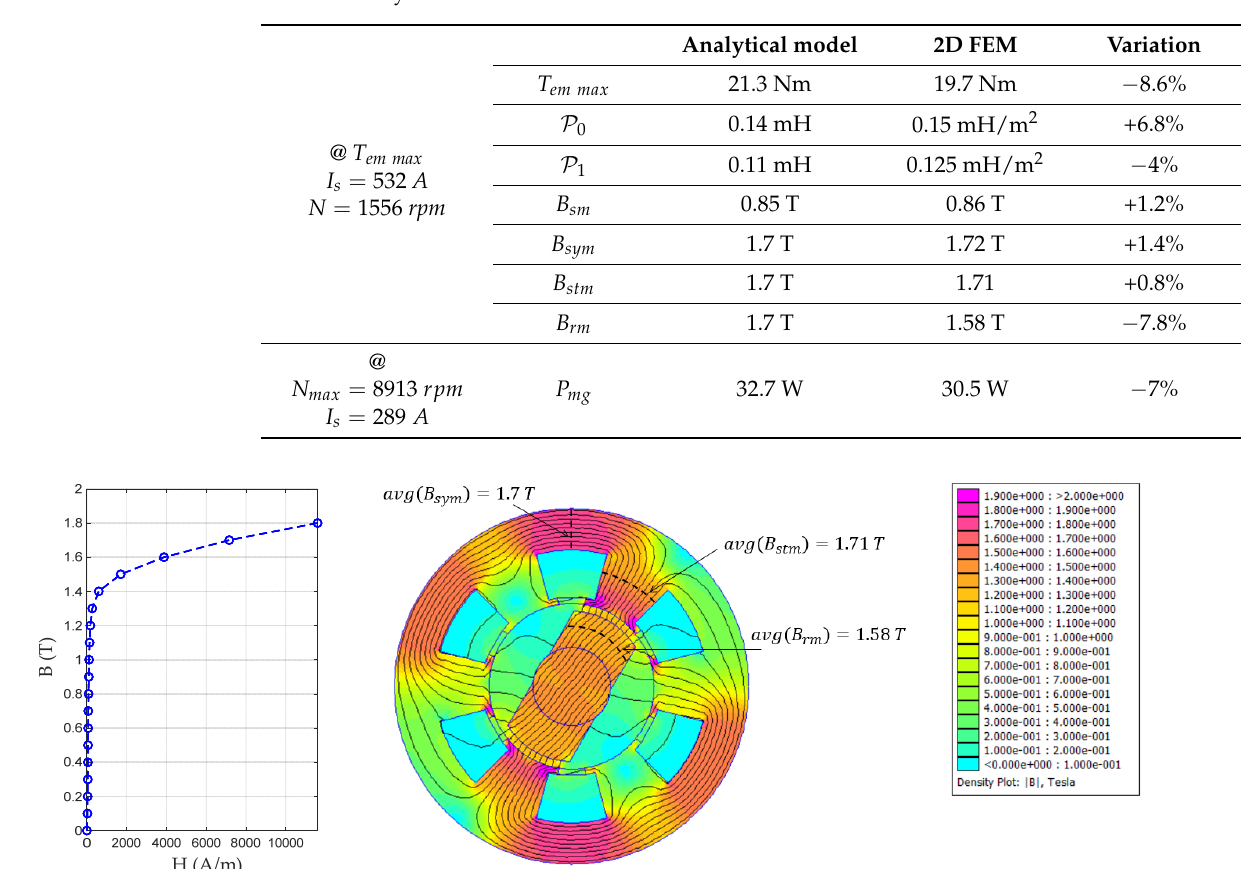
Table 6. Analytical and 2D FEM results.